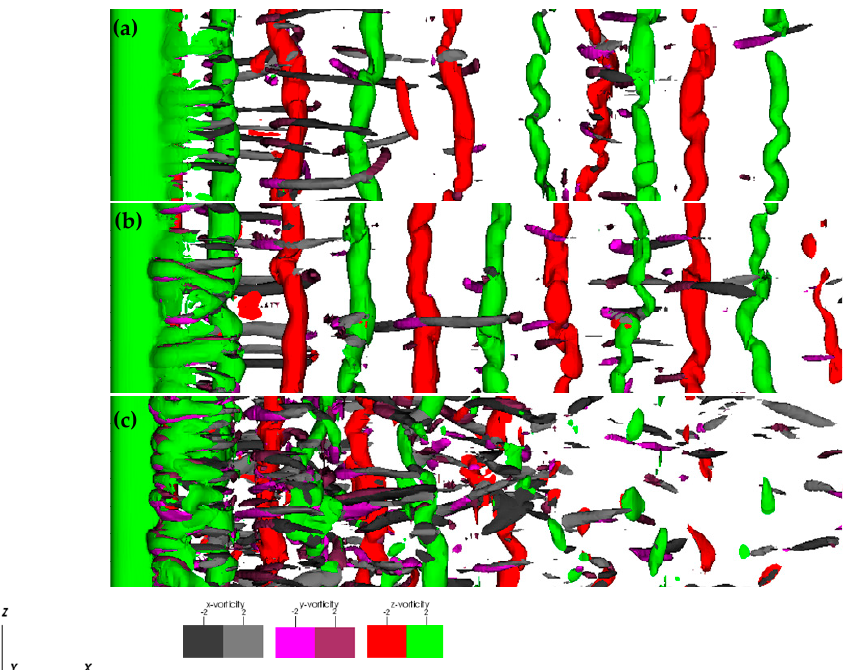
Figure 10. Counter-clockwise cylinder oscillation: Instantaneous vorticity isosurfaces (top view) for F = 0.9 and ( a ) A y /D = 0.20, ( b ) A y /D = 0.30, ( c ) A y /D = 0.60.